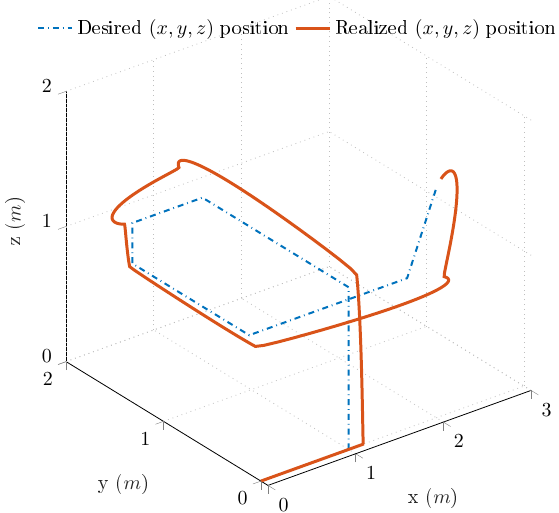
Figure 4. Reference and realized trajectories of the 6 DOF test bench in